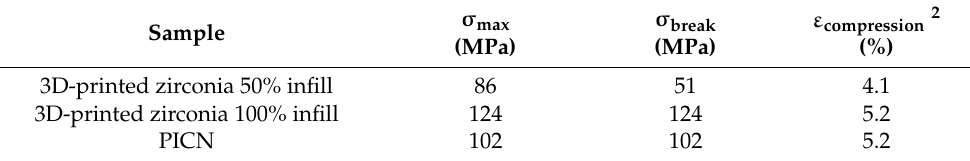
Table 2. Stress–strain data from the compression test 1